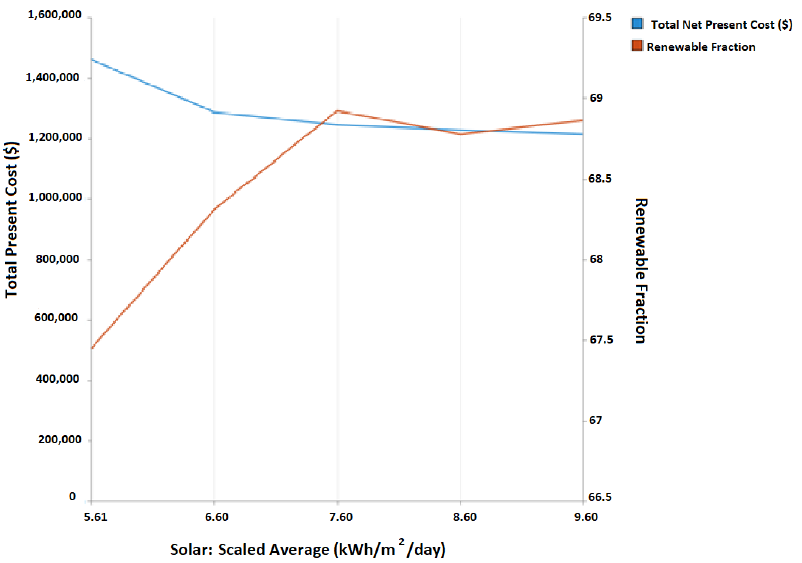
Figure 10. Sensitivity analysis of the renewable fraction and NPC based on average solar radiation.